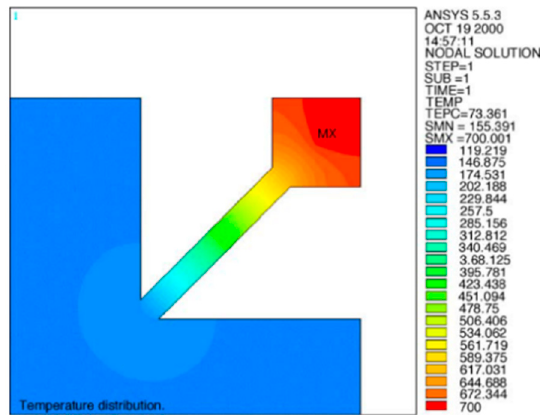
Figure 6. Temperature distribution of a suspended membrane microhotplate without gas sensitive layer (from [54]).